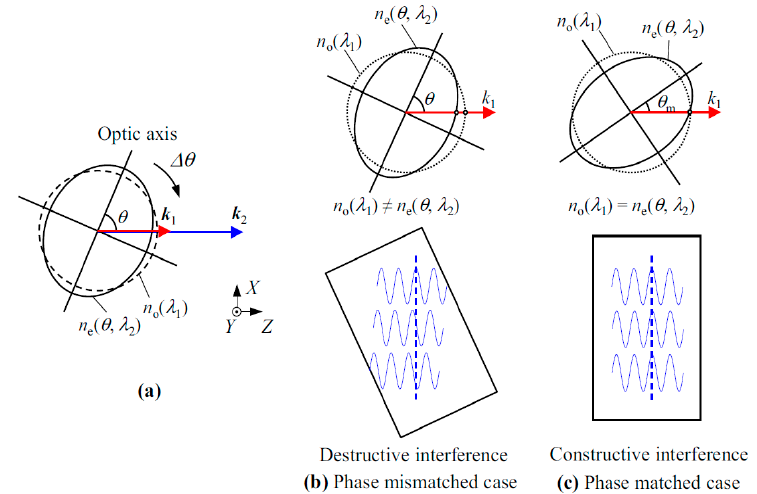
Figure 16. The matching angle in the second harmonic generation (SHG) [59]: ( a ) Refractive index ellipse of a negative uniaxial crystal; ( b ) Phase mismatched case; ( c ) Phase matched case.